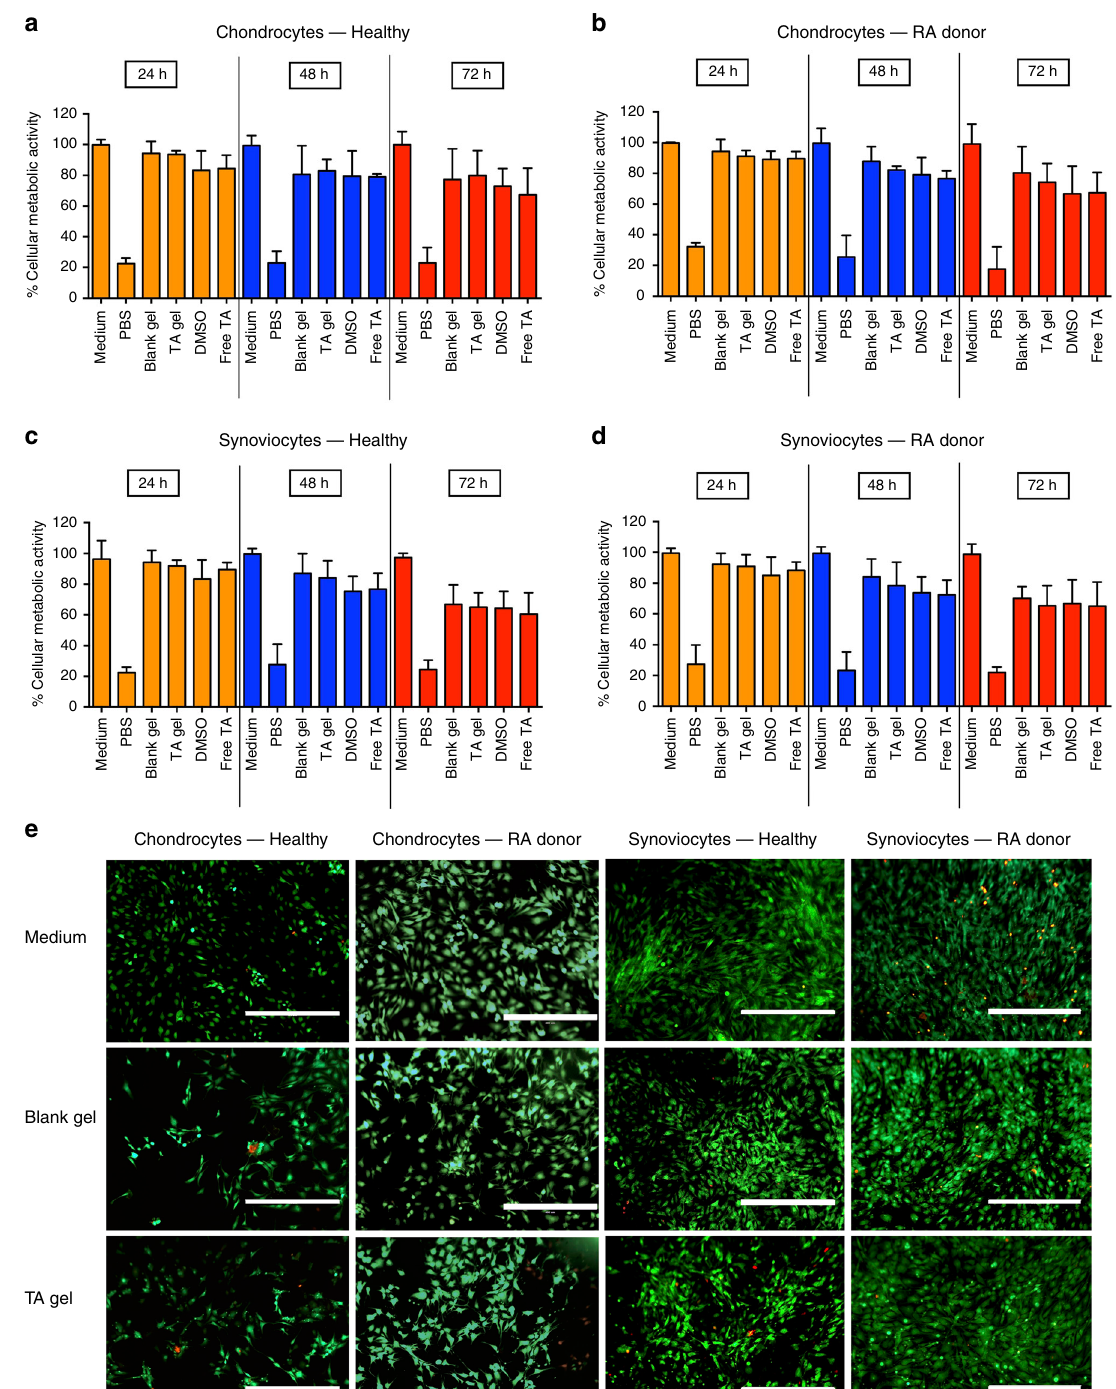
Fig. 3 TA-loaded hydrogel is biocompatible with cells from healthy and arthritic human joints. a – d Primary human chondrocytes or synoviocytes from healthy donors or RA patients were incubated in a 96-well transwell plate in medium, PBS, or in medium with 50 µ l blank hydrogel (Blank gel), 50 µ l TA- loaded TG-18 hydrogel (TA gel), DMSO (equivalent to 50 µ l hydrogel) or free drug (Free TA, equivalent to 50 µ l TA-loaded TG-18 hydrogel) added to the upper chamber of the transwell. After 24, 48, and 72 h of incubation, metabolic activity was determined by XTT assay. e Representative fl uorescence microscopy images after live/dead staining of primary human chondrocytes or synoviocytes from healthy donors or RA patients incubated for 72 h in medium or medium with blank hydrogel (Blank gel) or TA-loaded TG-18 hydrogel (TA gel) added to the upper chamber of the transwell (Scale bar: 400 µ m). Viable cells stain green with calcein-AM, whereas dead cells stain red with ethidium homodimer-1. Data in a – d are means ± SD of technical repeats ( n = 3, experiment performed at least